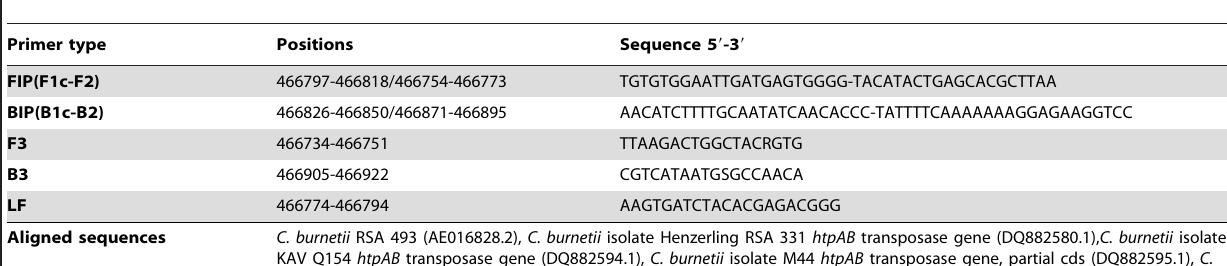
Table 2. Aligned sequences for designing primers and htpAB LAMP primer